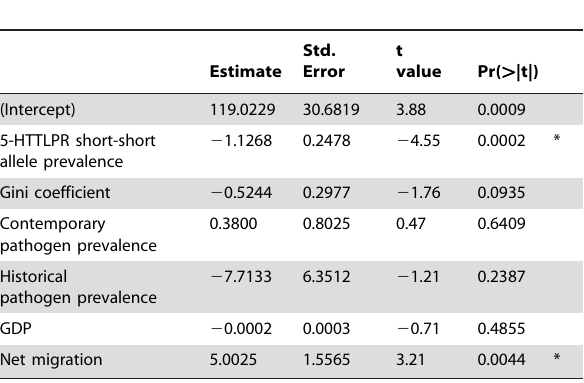
Table 2. Genes, collectivism and